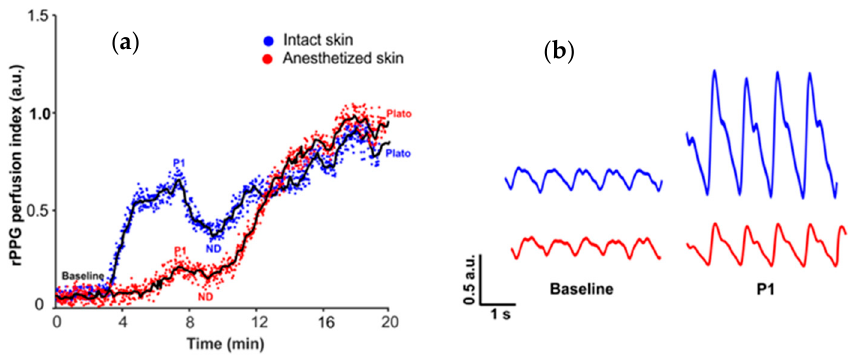
Figure 4. ( a )-Topical skin heating (VHP3 probe) induced vasomotor response in intact and anes-